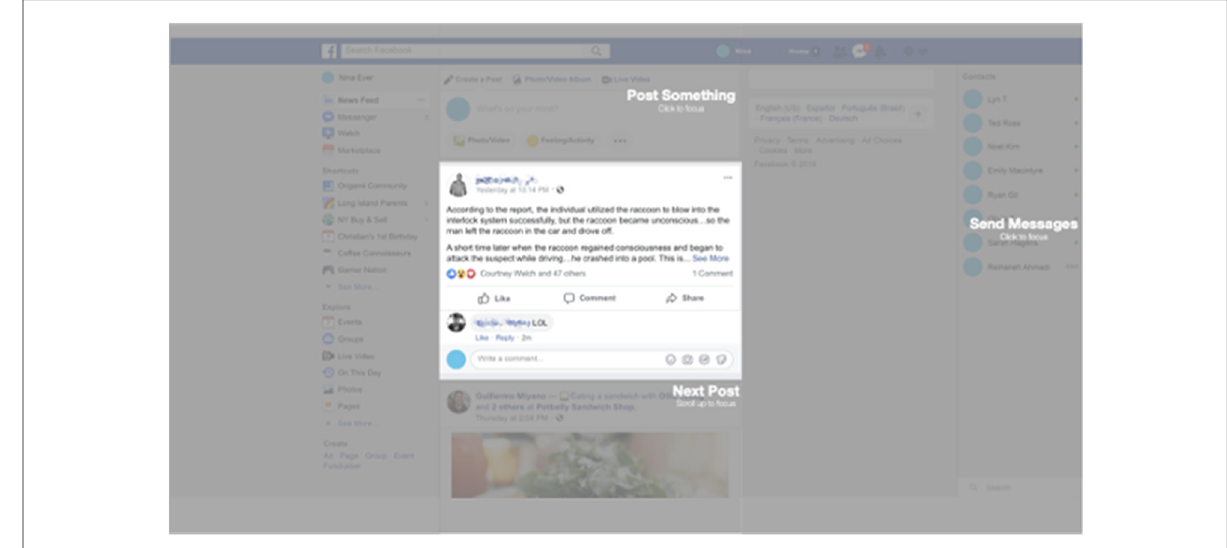
FIGURE 1 An example of modi fi ed Facebook page after using the attention aid. Identifying information such as names and faces have been blurred to protect con fi